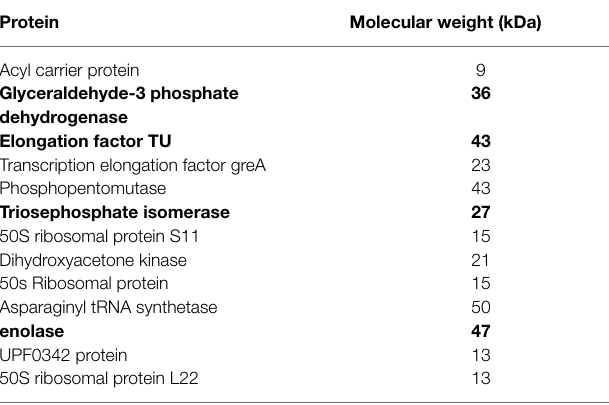
TABLE 3 | Proteins identified by tandem mass spectrometry in the F4 fraction of the lysate.